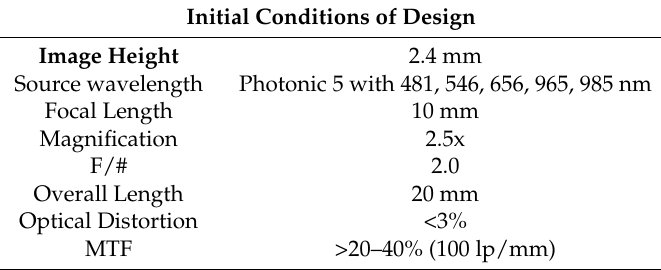
Table 6. Right angle prism inverted fixed focal system